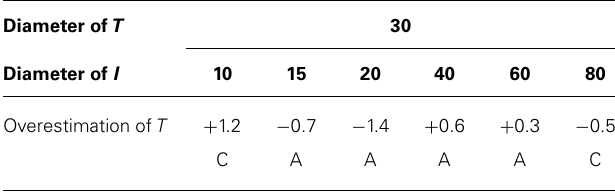
Table 1 | Underestimation and overestimation of the size of a circle, T = 30 mm, caused by another concentric circle, I , as observed by Ikeda and Obonai (1955).